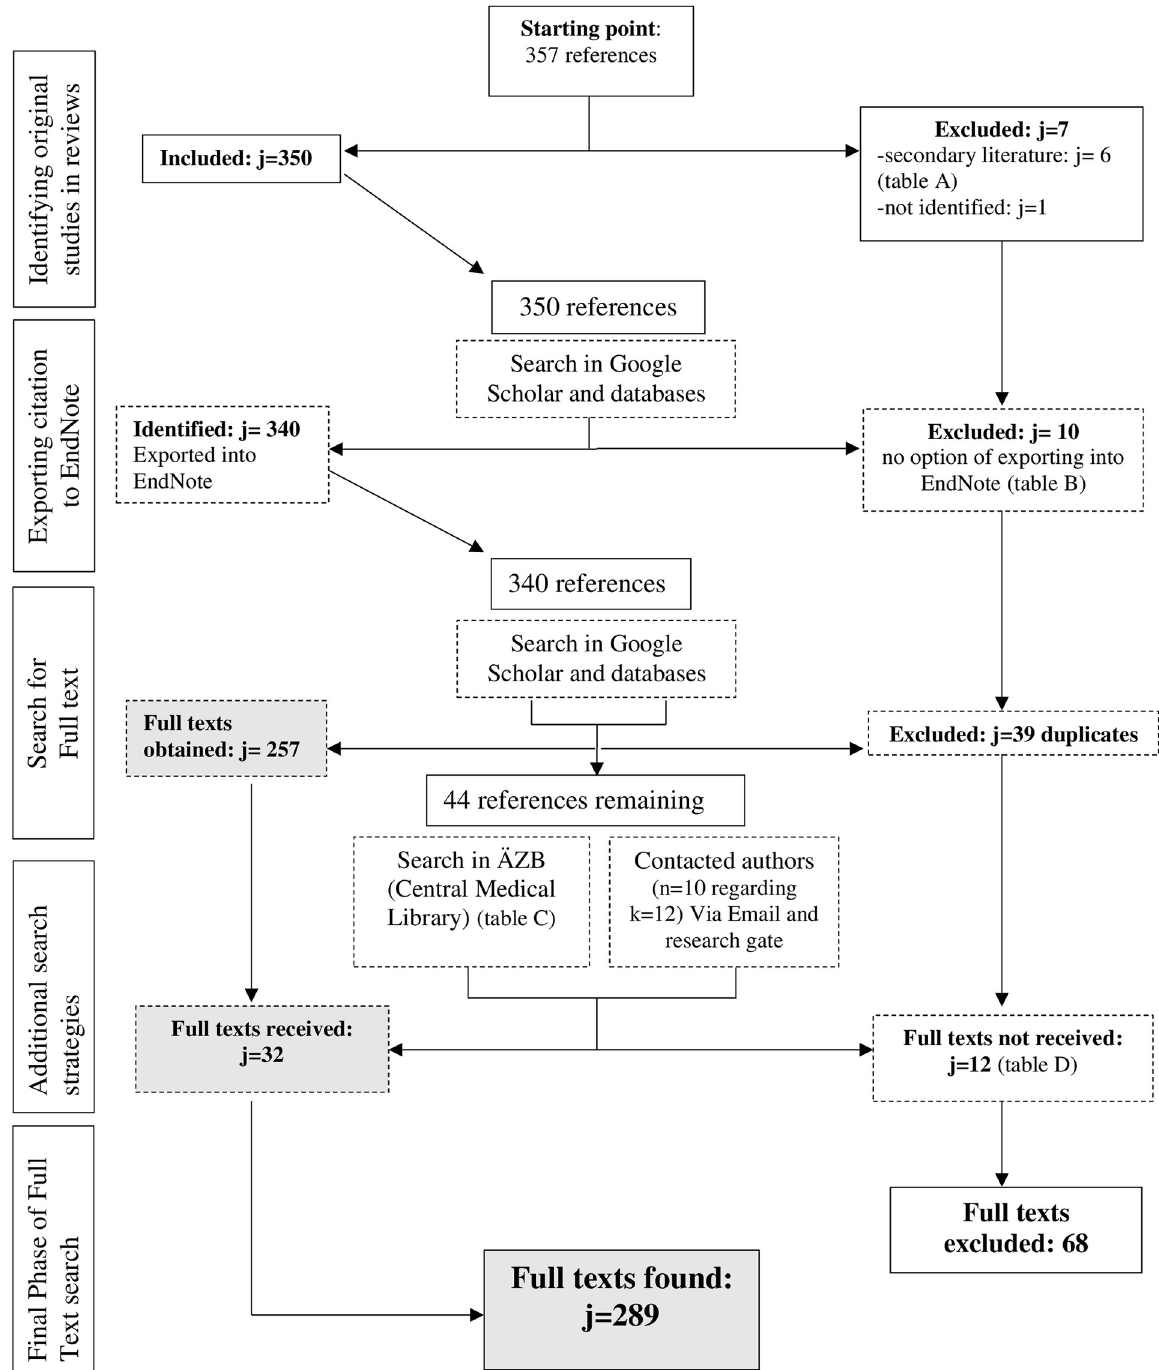
Fig 5. Flow chart of search process for full texts of primary studies .